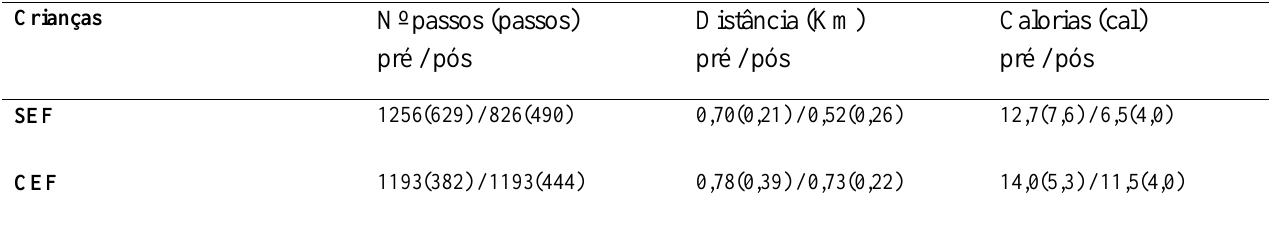
Tabela 3. Média e desvio-padrão do número de passos, estimativa da distância percorrida e do dispêndio calórico para as crianças sem aulas de educação física (SEF) e com aulas de educação física (CEF), no pré e pós-teste.